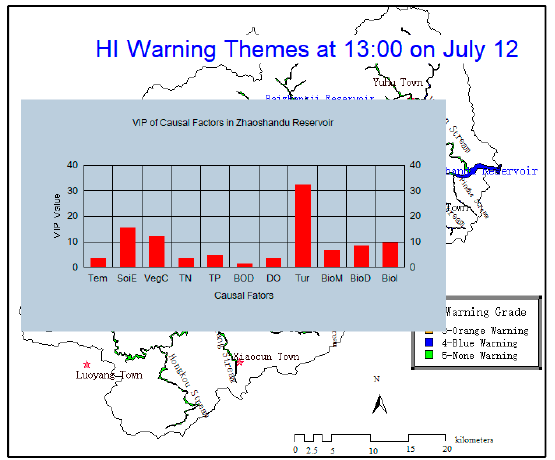
Figure 7. VIP s of different factors.